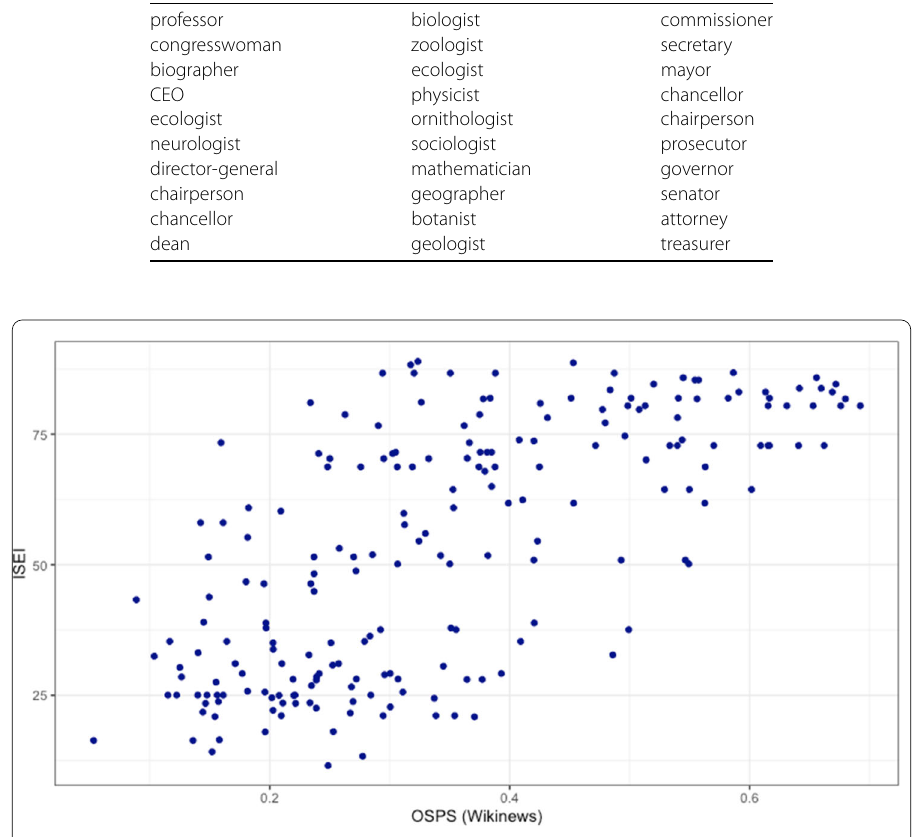
Table A2 Occupations with highest loadings, 3-factor solution, Wikinews_subwords Factor 1